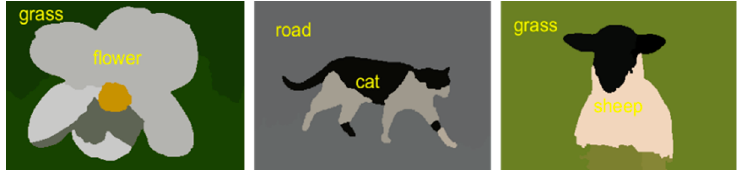
Figure 8. Results of object categorization using multiple kernel learning.